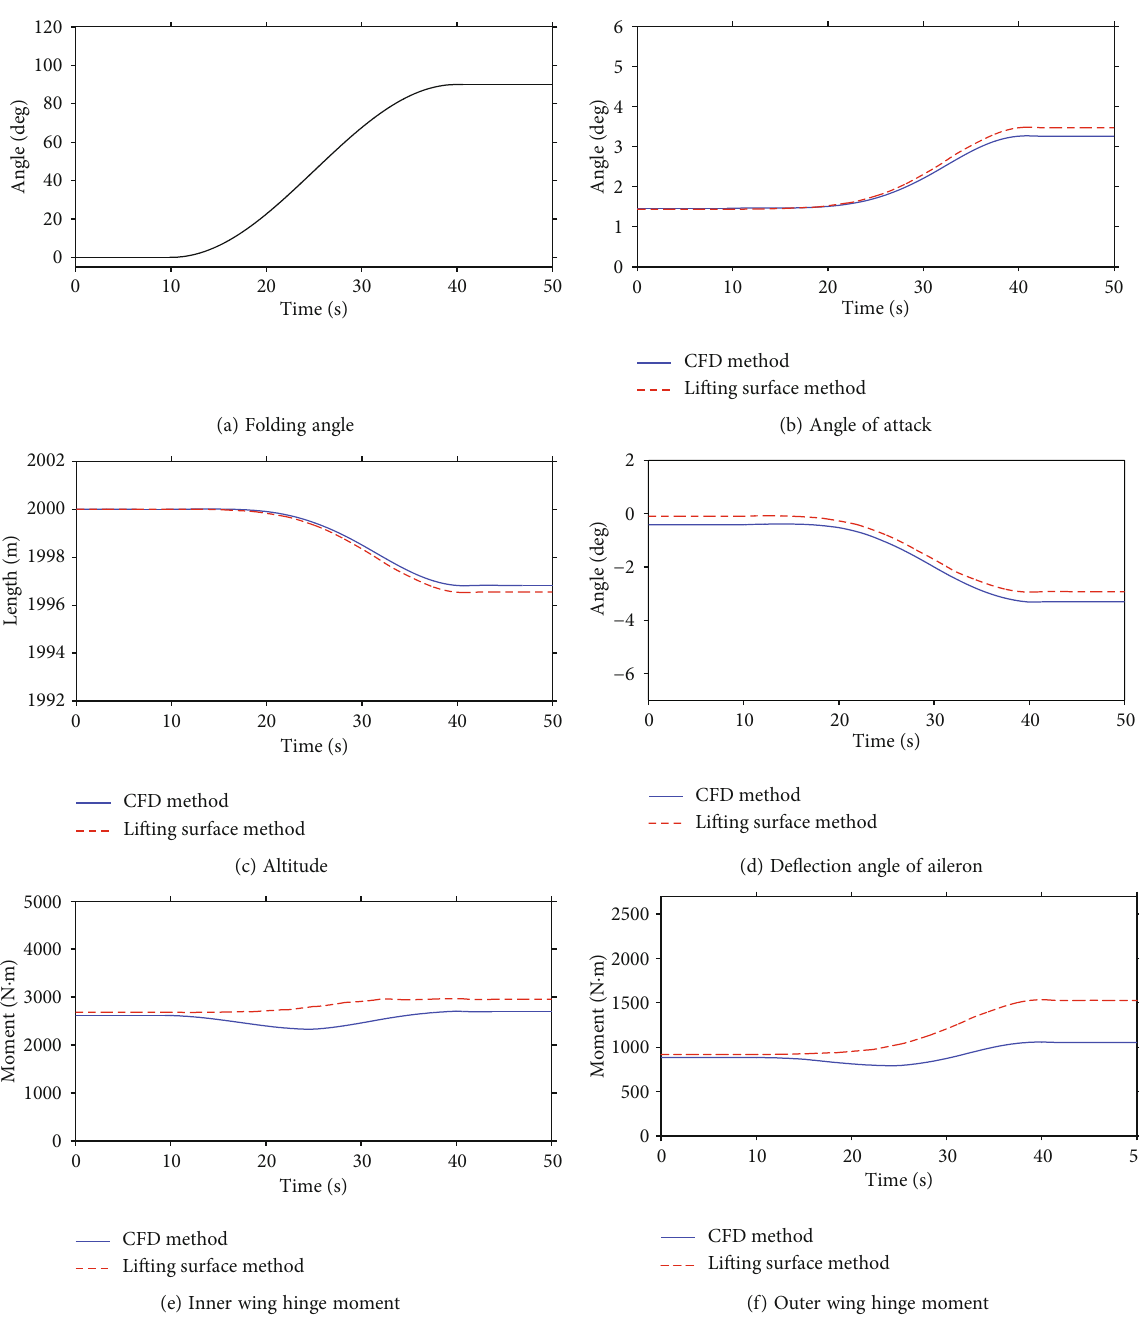
Figure 13: Comparison of simulation